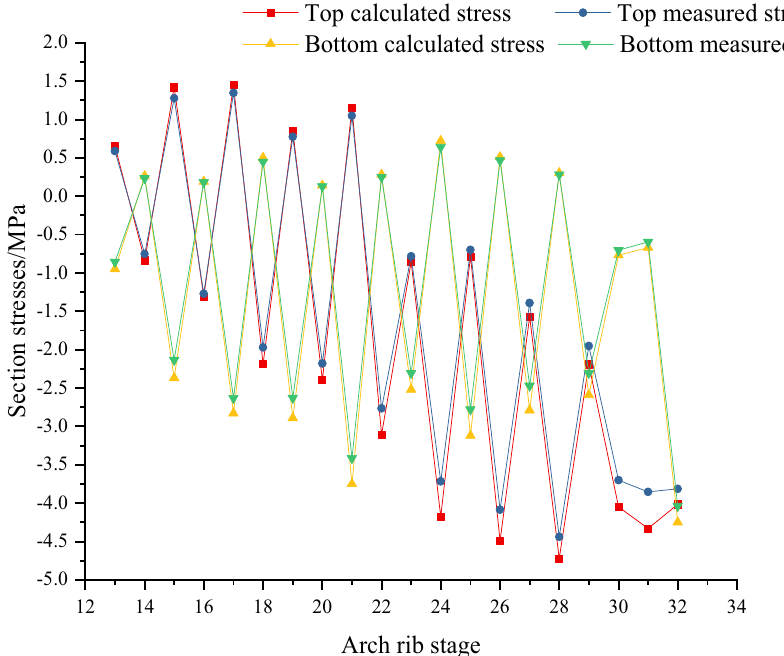
Figure 24. Calculated and measured stresses of key section No. 7 in the process of arch rib